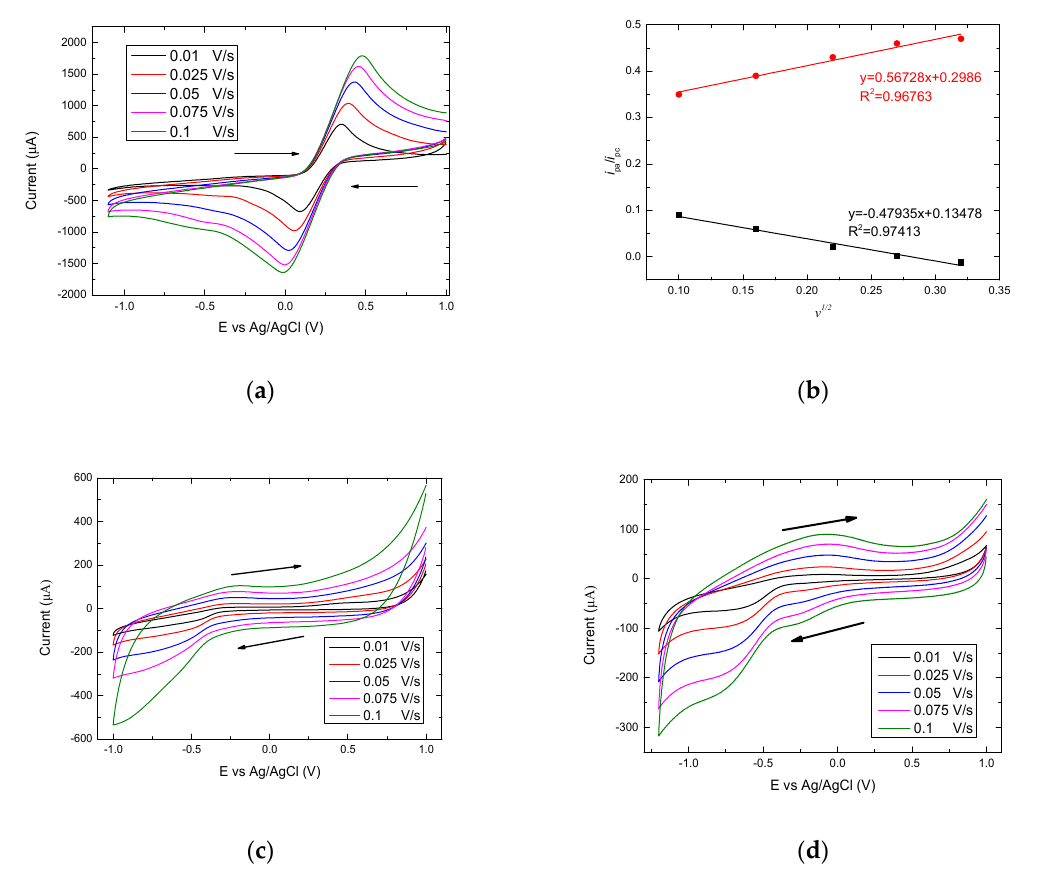
Figure 3. Cyclic voltammograms (CVs) of ( a ) a bare graphite/SiO 2 film electrode in 0.1 M KCl solution containing 5 mM of [Fe(CN)6] 3 − /4 − at different scan rates. ( b ) Plot of anodic and cathodic peak current (Ipa/Ipc) vs. square root of scan rate ( v 1/2 ). ( c ) A bare graphite/SiO 2 film electrode in 10 mM NaH 2 PO 4 , pH 7.0 at different scan rates and ( d ) the OM-(KG) 5 -MOG 35-55 conjugate on graphite/SiO 2 in 10 mM NaH 2 PO 4 , pH 7.0 at different scan rates under an Argon atmosphere.